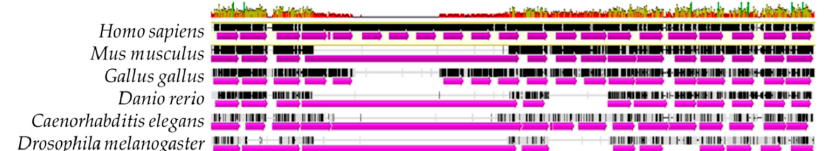
Figure 2. Conservation of HSPG2 among common animal models. The perlecan domain IV cDNA sequence was analyzed in Homo sapiens (human), Mus musculus (mouse), Gallus gallus (chicken), Danio rerio (zebra fish), Caenorhabditis elegans (nematode), and Drosophila melanogaster (fruit fly). The alignment was performed using the software Geneious v5.4 [48]. The top graph represents consensus sequence identity among the species examined, with green and red representing high and low base pair conservation amongst all the listed organisms. All sequences are compared to HSPG2 of Homo sapiens , which is highlighted in yellow at the top of the list. Sequences are shown in a grey color scale, representing low (white) to high (black) similarity to that of the reference cDNA sequence. The purple arrows parallel the sequence of individual Ig